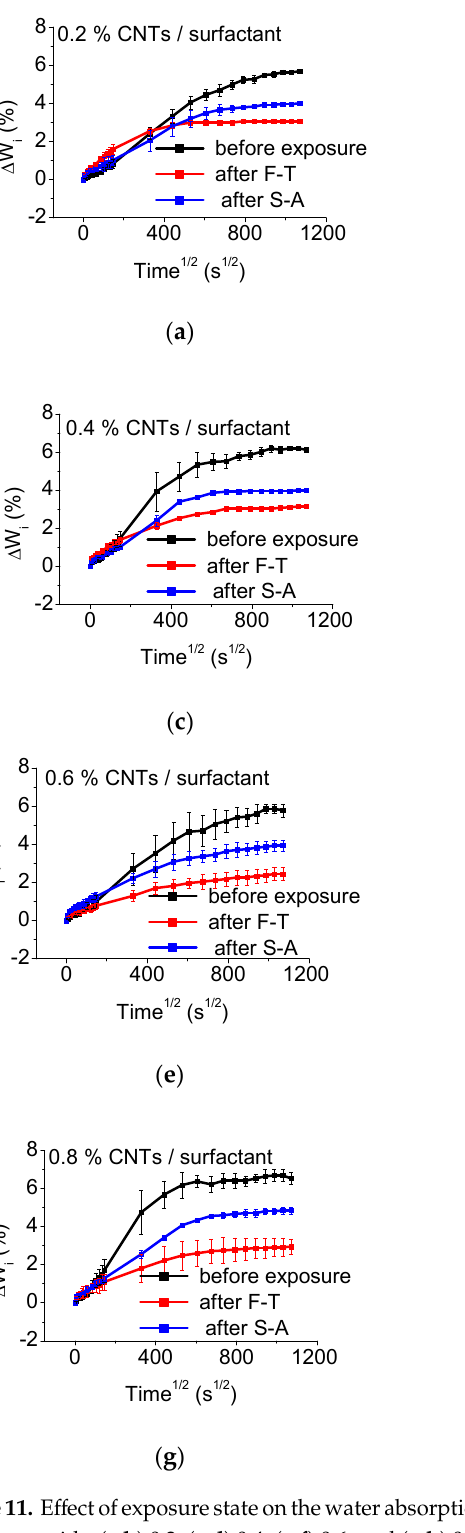
Figure 10. Effect of exposure state on the water absorption ( a , c , e , g ) and gas permeability ( b , d , f , h ) profiles of mortars with: ( a ), ( b ) 0.2, ( c ), ( d ) 0.4, ( e ), ( f ) 0.6, and ( g ), ( h ) 0.8 wt.% CNT contents, prepared using superplasticizer as dispersant.